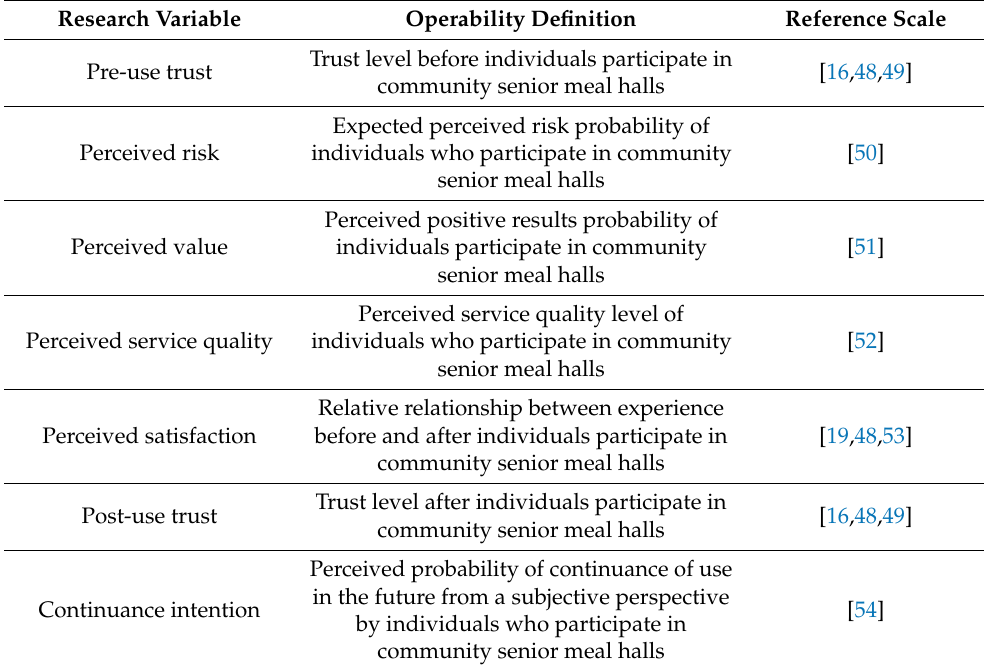
Table 1. Definition of variable operability and reference